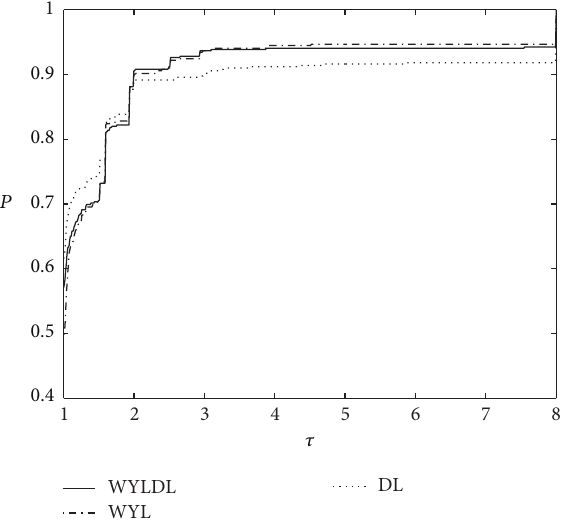
Figure 3: Performance profiles based on CPU time. From Figure 2, which plots the performance profile based